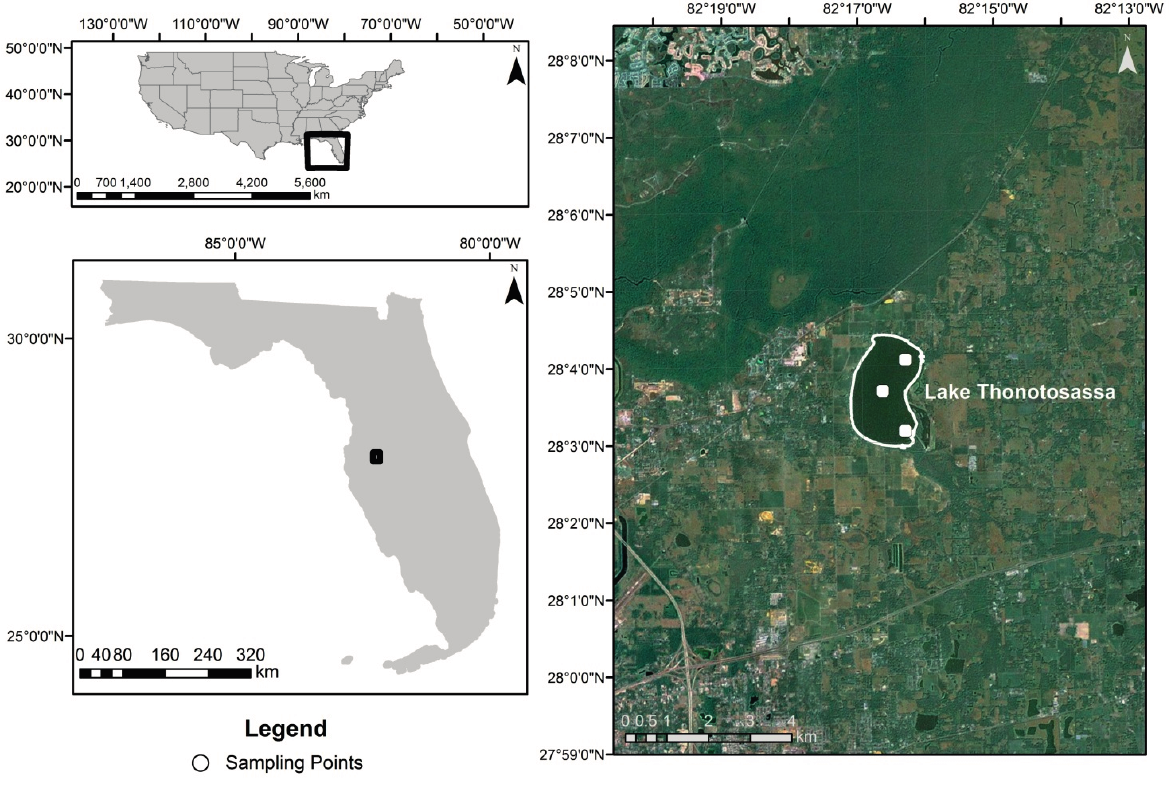
Figure 1. Location of Lake Thonotosassa in the State of Florida, USA, and the location of sampling points from the Environmental Protection Commission of Hillsborough